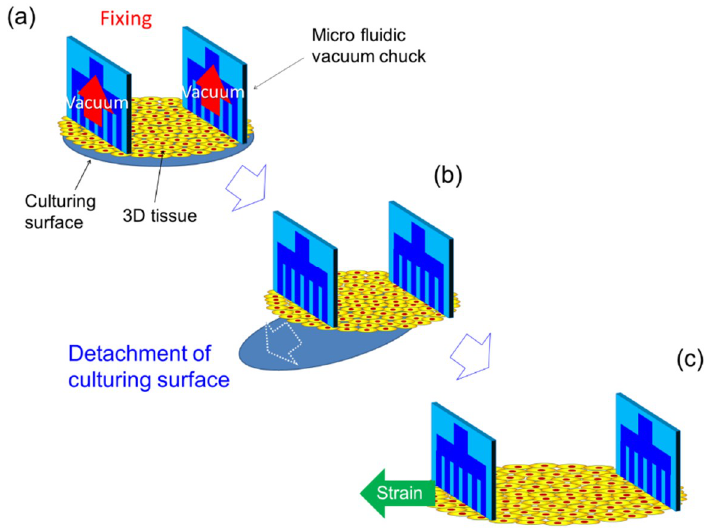
Figure 4. Schematic illustration of 3D tissue fixation by the micro vacuum chuck (MVC). ( a ) The 3D tissue, on a culturing surface that consisted of a culturing insert membrane, was fixed by the MVCs using the vacuum pressure. ( b ) The culturing surface was detached from the 3D tissue. ( c ) The 3D tissue was strained in one direction and beating force was measured.